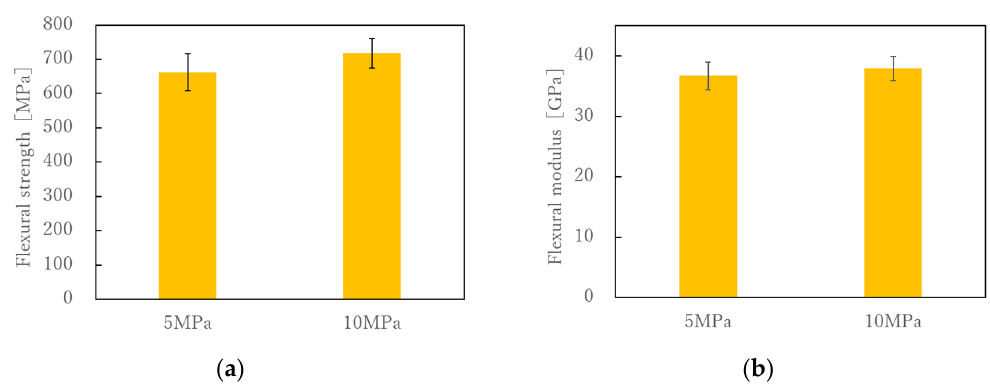
Figure 12. ( a ) Effect of molding pressure on flexural strength under molding time of 30 min; ( b ) Effect of molding pressure